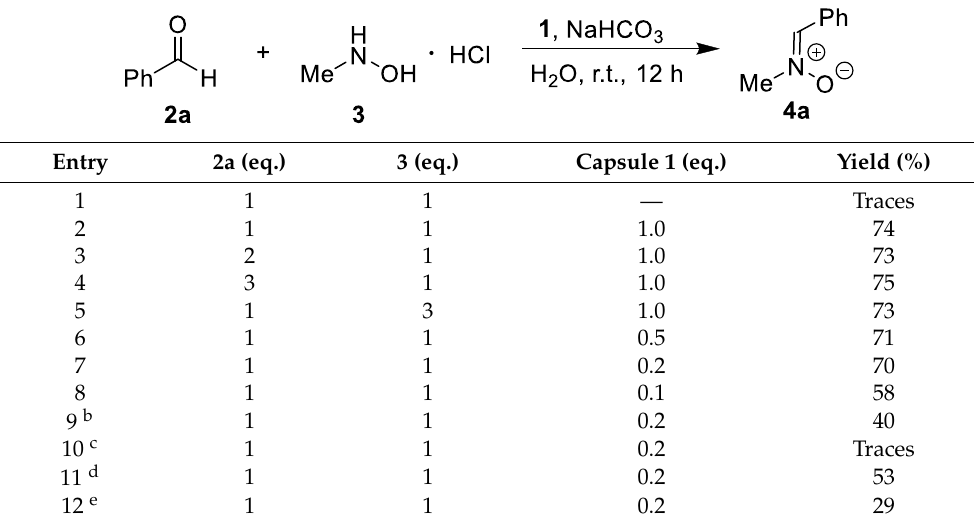
Table 1. Optimization of the reaction conditions between aldehyde 1 and N -methylhydroxylamine 2 a .